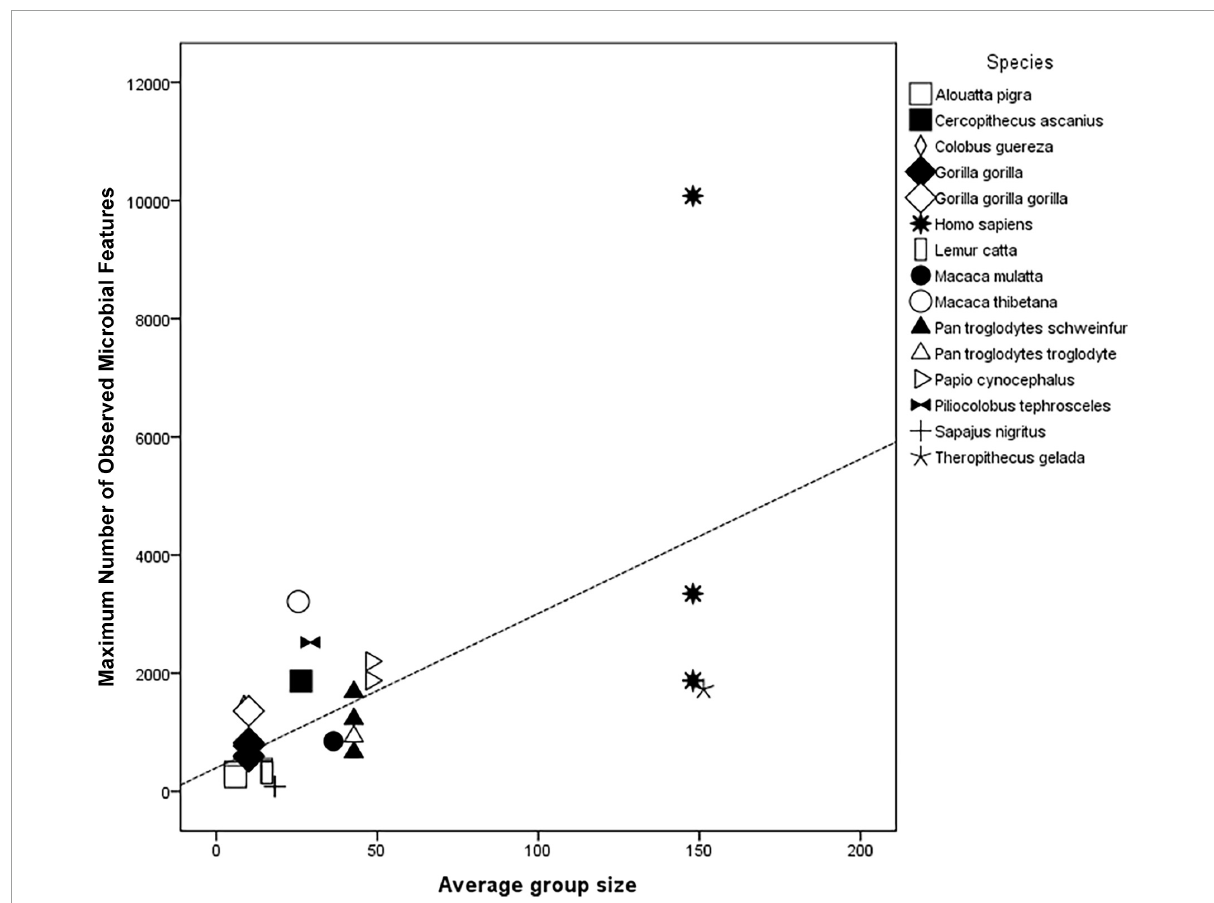
FIGURE3 Scatterplot for regression results of species’ specific Average group size for 15 primate species (including Homo sapiens ) as predictor of their Maximum number of observed microbial features (OTUs or ASVs); R 2 = 0.42; Adj R 2 = 0.40; F (3,30) = 20.7, P < 0.001; N =